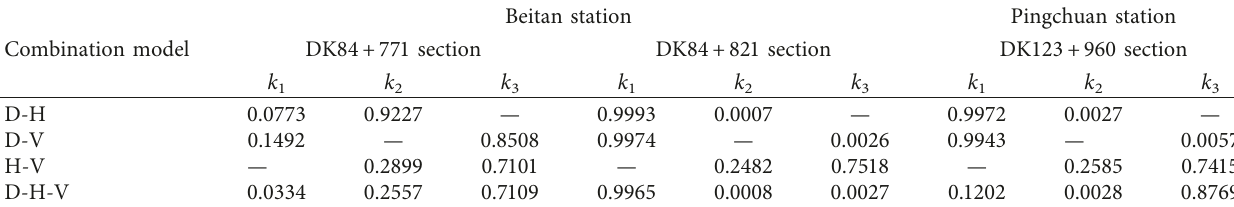
Table 4: Optimal weight coefficient of combined prediction model.